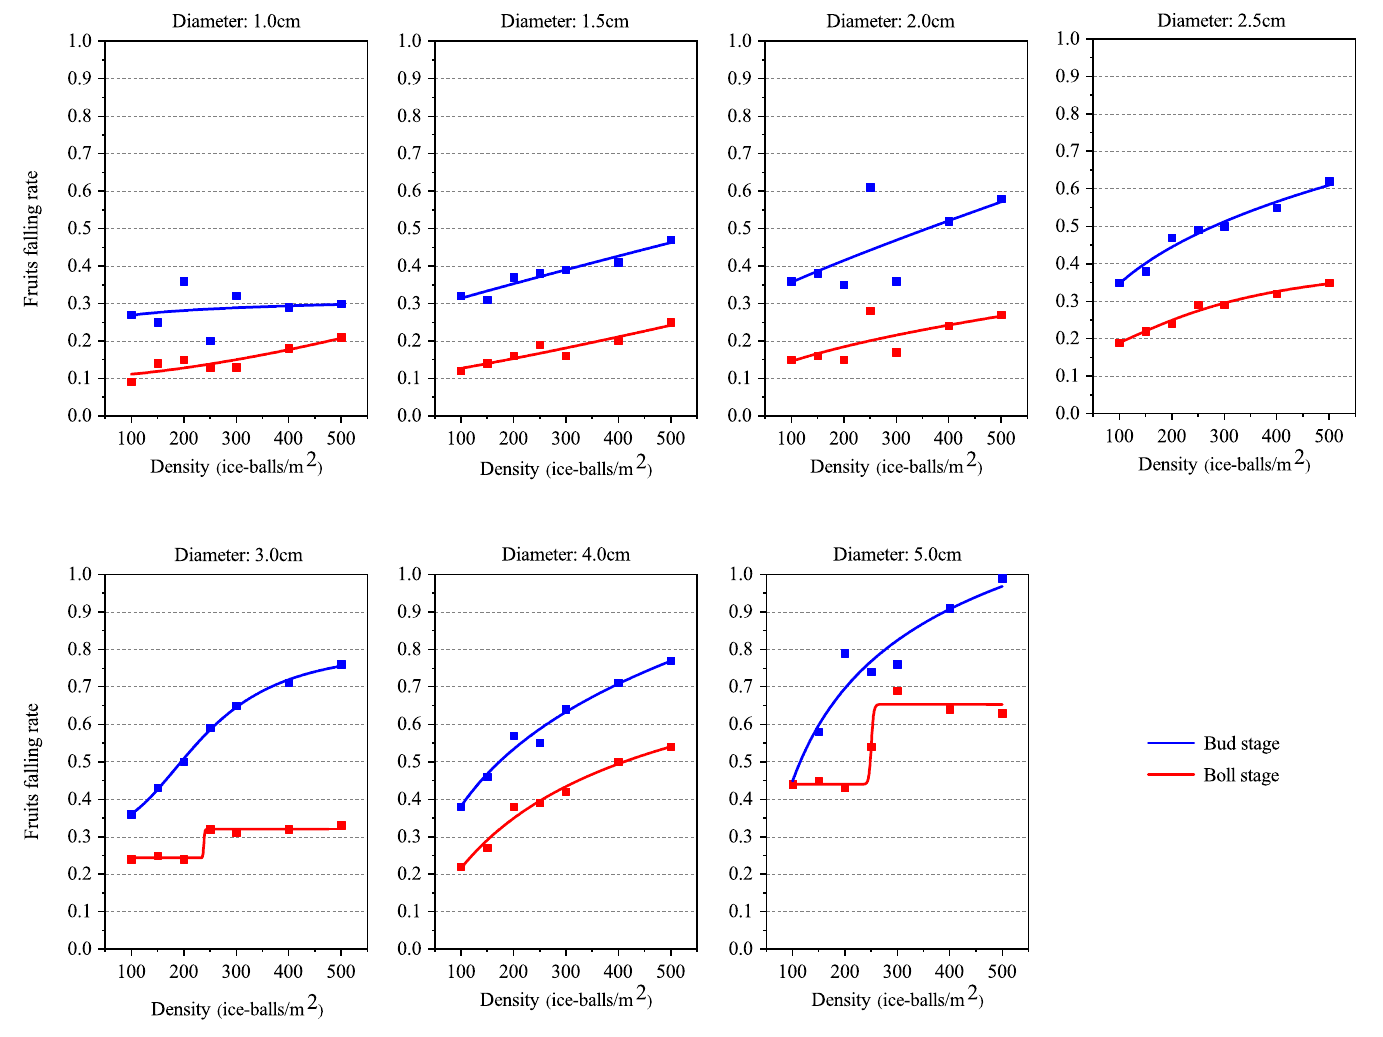
Fig 6. Logistic function between the boll falling rate and hail fall density.